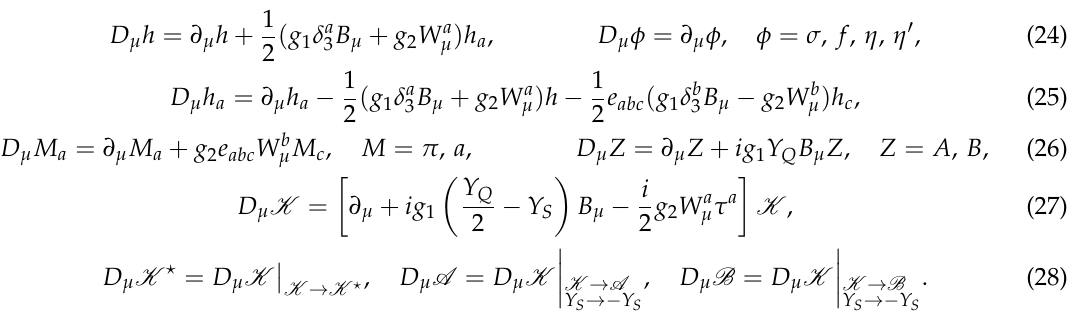
Table 1. The lightest (pseudo)scalar H-hadrons in Sp ( 2 χ ˜ c ) model with two and three flavors of H-quarks (in the limit of vanishing mixings). The lower half of the table lists the states present only in the three-flavor version of the model containing the singlet H-quark S . T is the weak isospin. ˜ G denotes hyper- G -parity of a state. ˜ B is the H-baryon number. Q em is the electric charge (in units of the